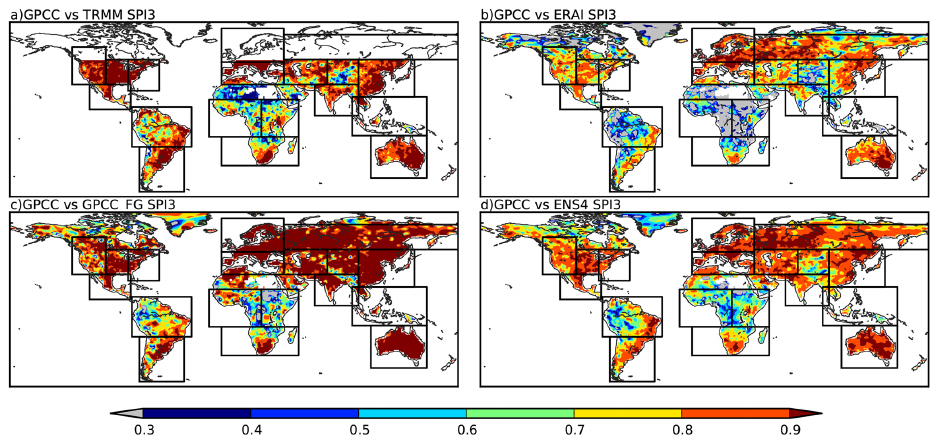
Figure 6. Temporal grid-point correlations of the GPCC SPI-3 (2009-2012) versus (a) TRMM, (b) ERAI, (c) GPCC_FG, and (d) ENS4. Correlations below 0.3 or not statistically significant different from zero are displayed as grey.